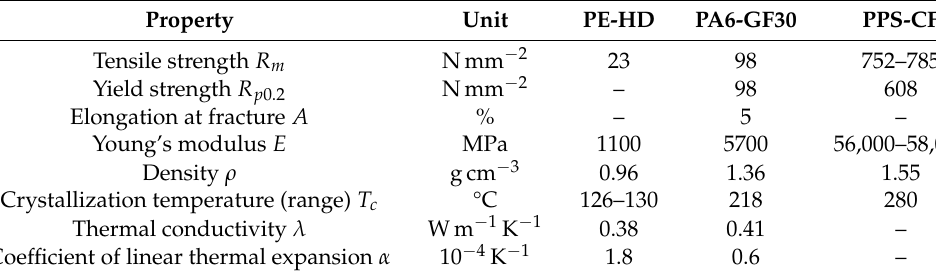
Table A2. Selected mechanical and thermal properties of the plastic components used [24,27,31]. Property